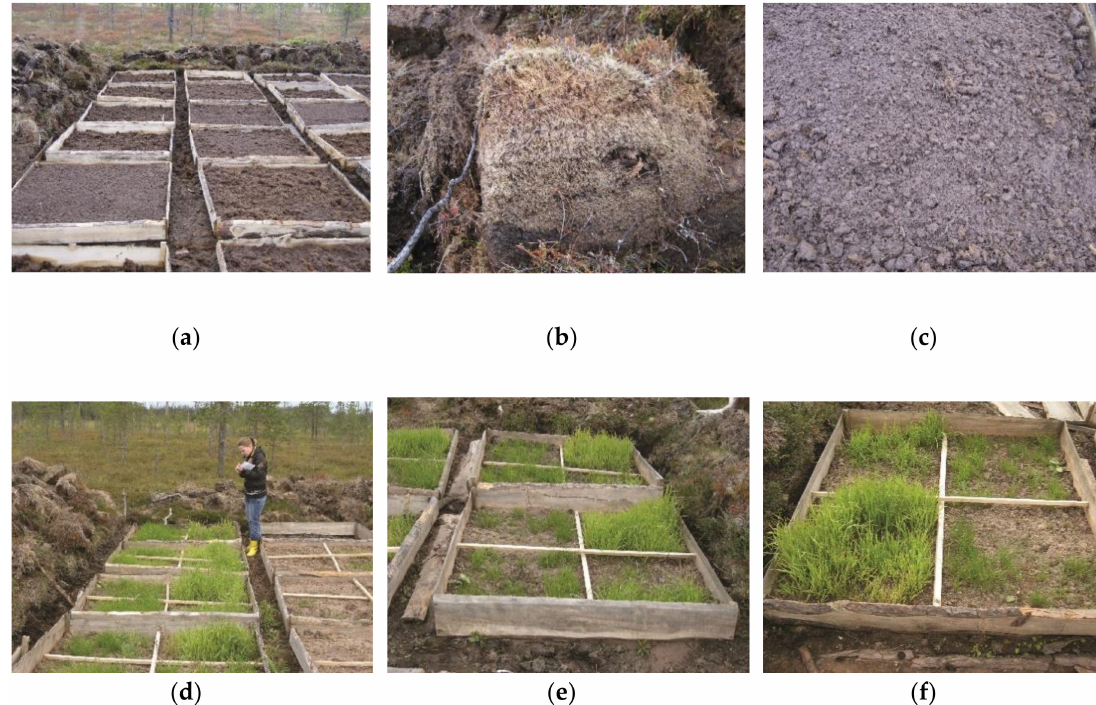
Figure 5. Experimental plots for perennial grass cultivation as a part of the reclamation procedure in the transitional peat bog within the boundaries of the Severalmaz allotment: ( a ) a fragment of the test site prior to herb sowing; ( b ) poorly decomposed top 25–30 cm Histosol horizon; ( c ) a separate bed of a control sample mixture of peat and enrichment waste; ( d ) a fragment of the experimental plot with perennial grasses in one year; ( e , f ) separate beds with di ff erent grass responses to growing